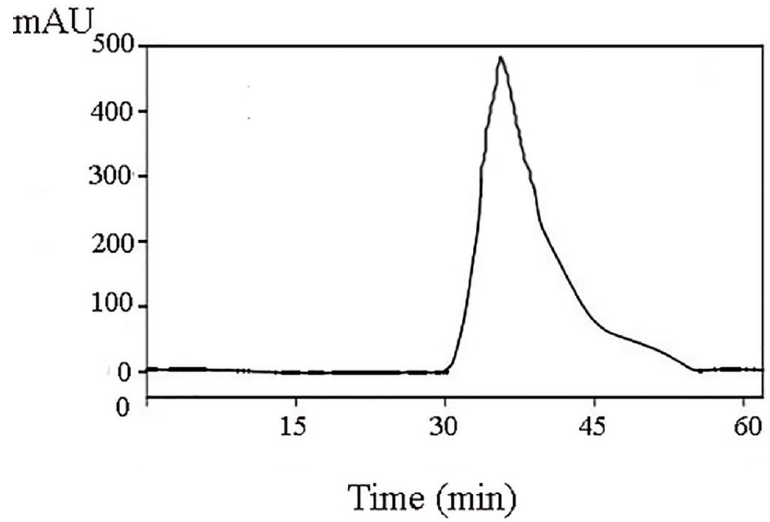
Figure 5. Purification of A1-2 by RP-HPLC.